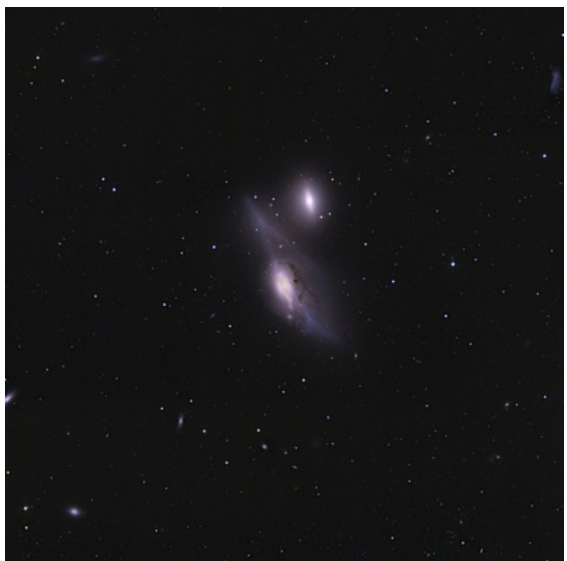
Figure 1. False-colour image of the galaxy NGC 4438, one of our sample galaxies classified as Class B in [13]—recognising its highly distorted morphology indicative of the galaxy undergoing an interaction. Image courtesy of DAGAL, Nik Szymanek, SDSS, and S 4 G, www.dagalnetwork.eu.